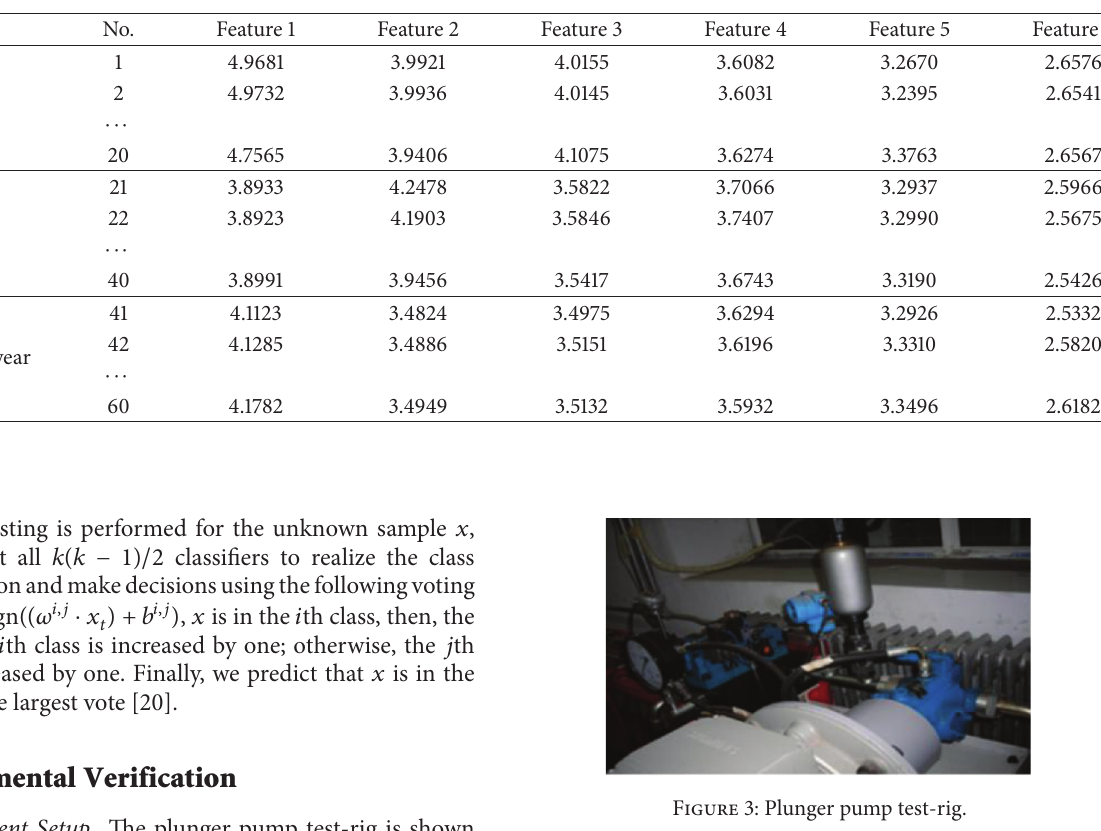
Table 1: Six-dimensional fault features.